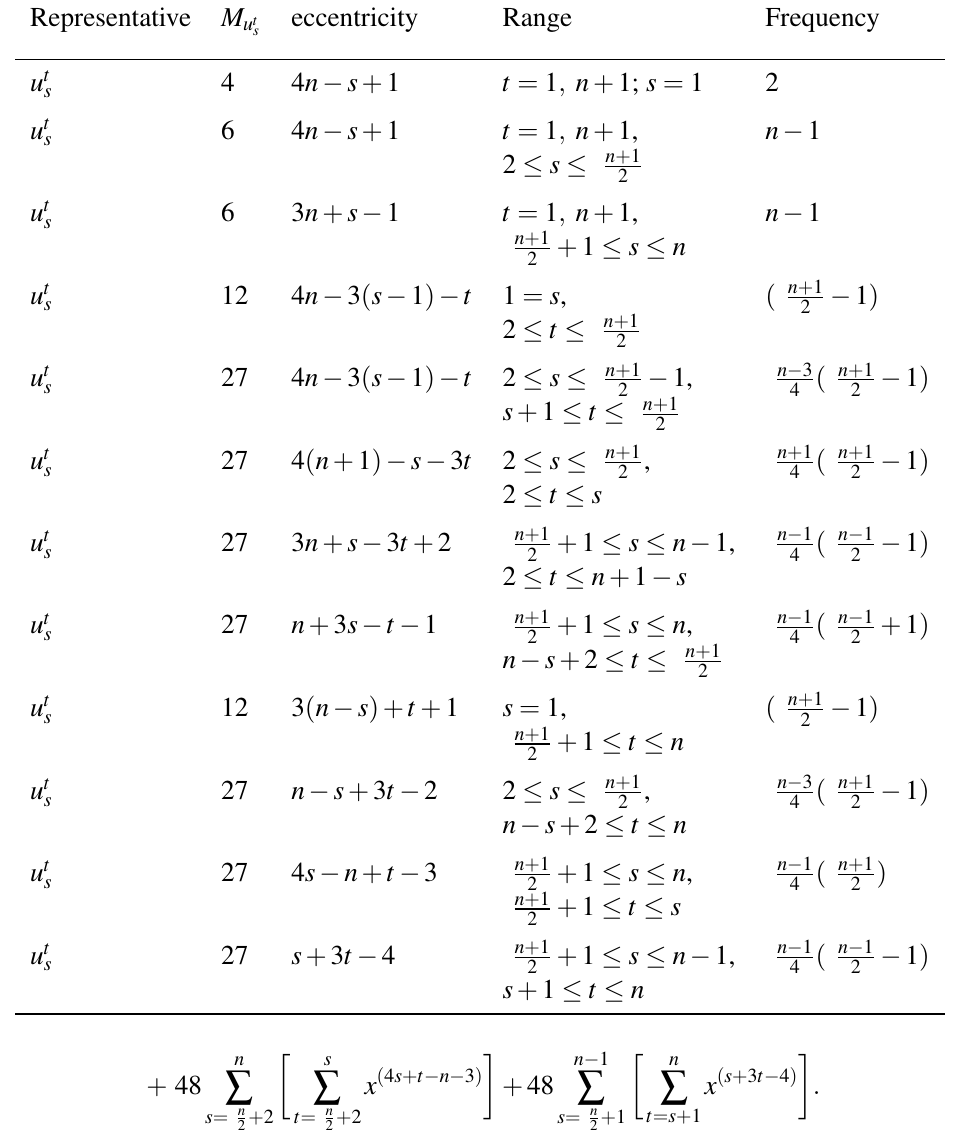
Table 4 Partition of vertices of the type u t mod 2 )